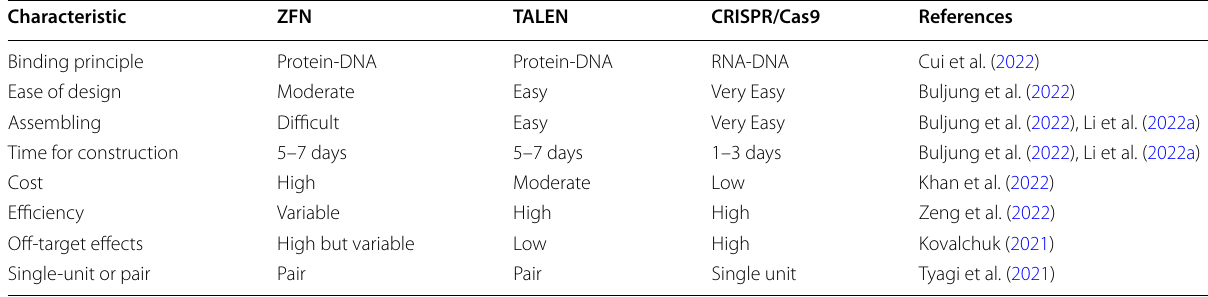
Table 1 Characteristics of various gene editing tools Characteristic ZFN